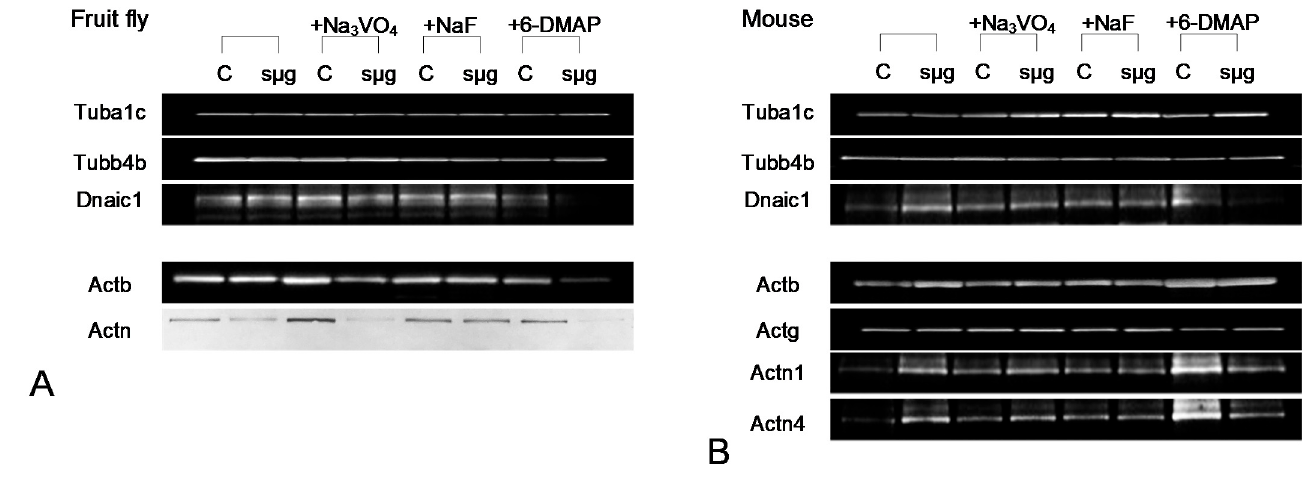
Figure 3. Typical western blot pictures. ( A ) Drosophila melanogaster proteins. ( B ) mouse sperm proteins.